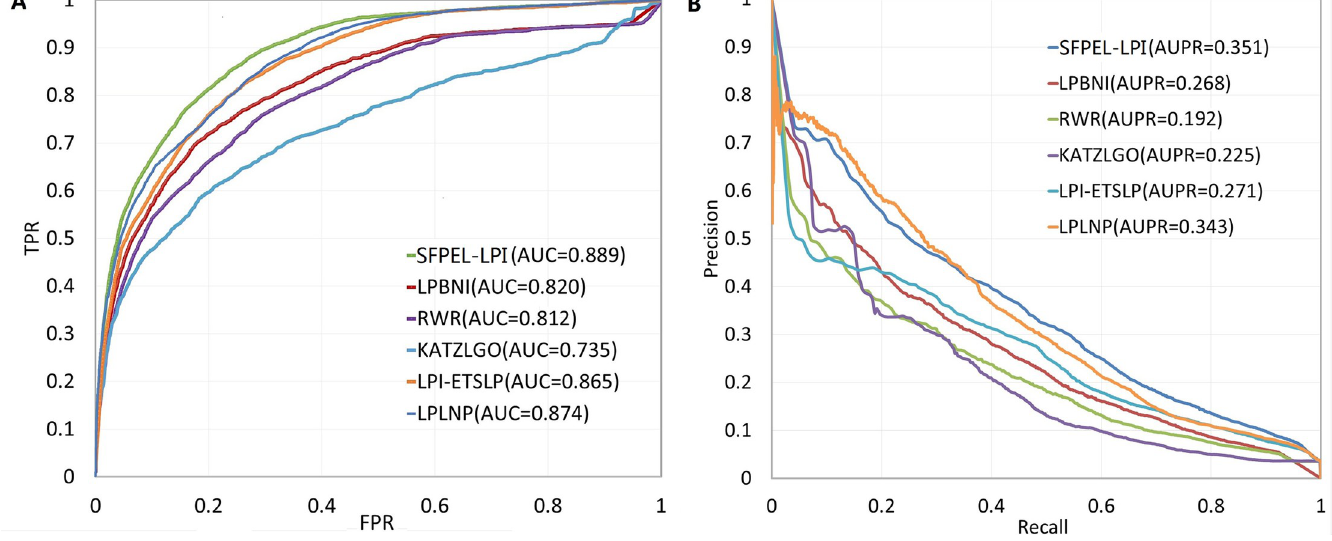
PLOS Computational Biology | https://doi.org/10.1371/journal.pcbi.1006616 December 11,